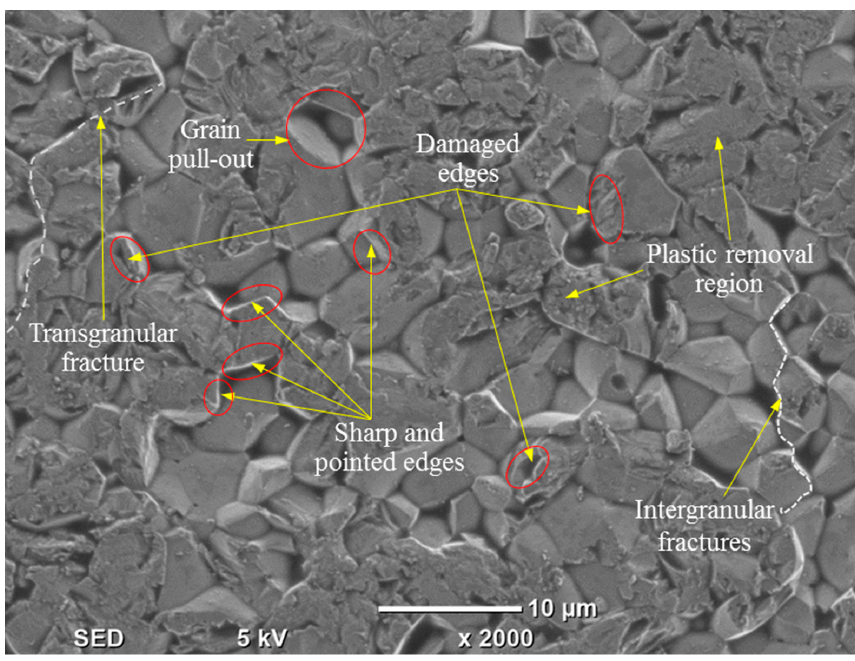
Figure 7. The microstructure of processed surface for Exp. #17.